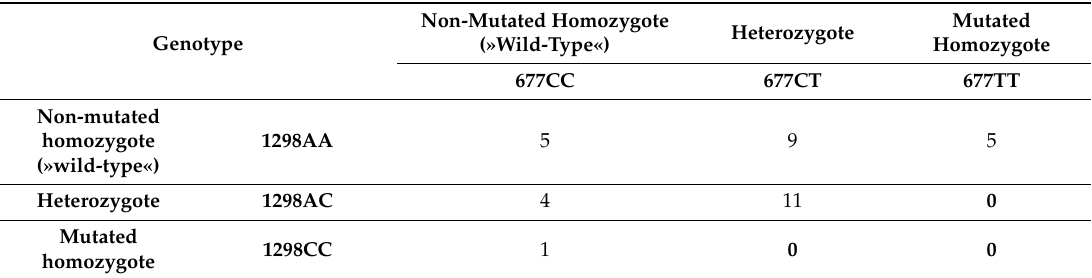
Table 1. Number of LCL cells according to MTHFR C677T and A1298C